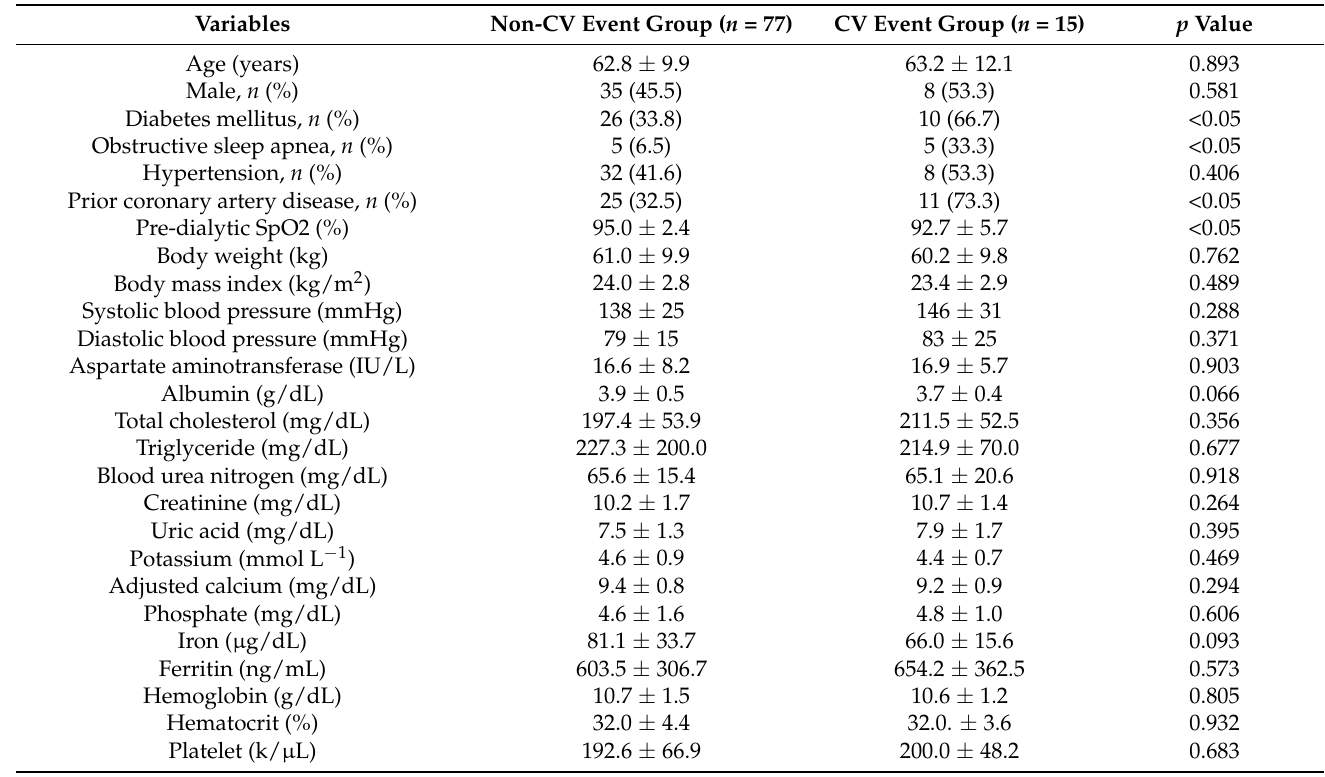
Table 3. The comparison bio-clinical parameters between non-CV event group and CV event group according to CV mortality.